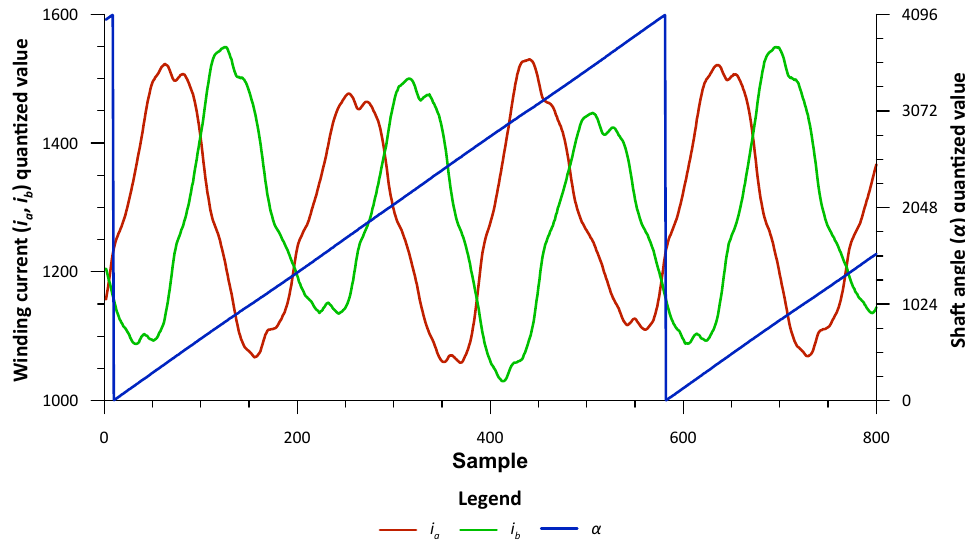
Figure 7. Current measurement cycle timing.